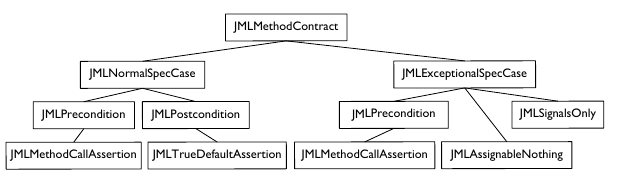
Figure 9. A Sample AST templateforProducingJMLSyntax.